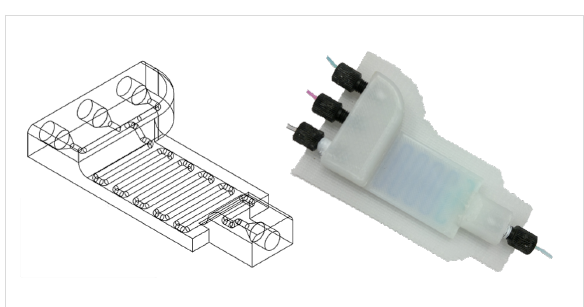
Figure 1: On the left is a schematic presentation of the STL file, whilst on the right is the device with screw fittings and connected with 1/16 inch (1.6 mm) tubing. Methylene blue and rhodamine B are being pumped through the device, which allows the inner-tube path to be rendered visible. A section consisting of only methylene blue can be seen at the front, followed by a stronger purple band, which is obtained from the successful mixing of rhodamine B and methylene